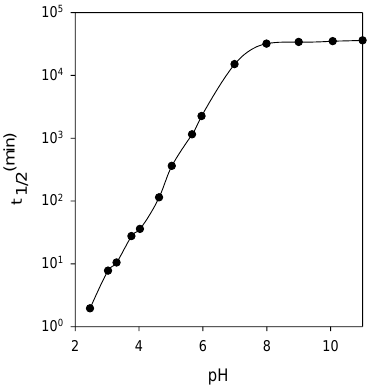
Figure 9. The half-life time of ethyl xanthate as a function of pH (adapted from Allison [32]).